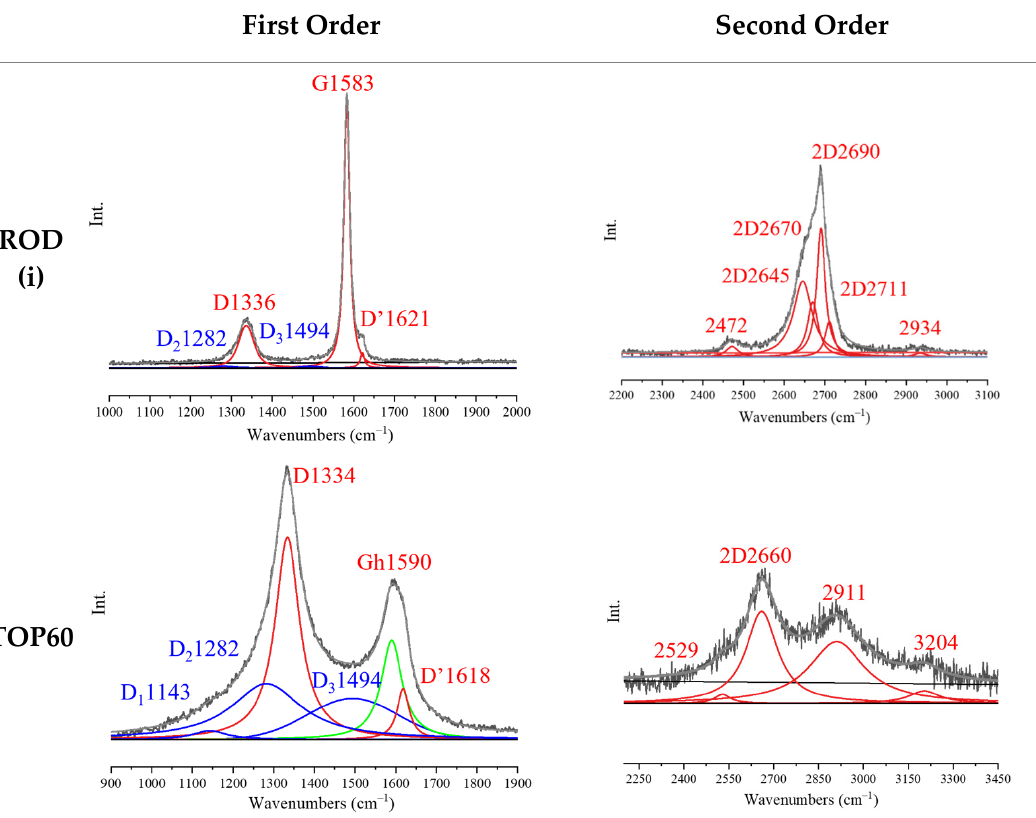
Figure 8. Result of the curve fitting (deconvolution) of the Raman spectra ( λ exc = 633 nm) of ROD(i) sample and of TOP60 sample. Table 4. Parameters obtained after deconvolution of the Raman spectra ( λ exc = 633 nm) of the samples listed in the first column. Full Width at Half Maximum (FWHM) of the G or G h line are listed in squared brackets after peaks wavenumbers (columns II and III).